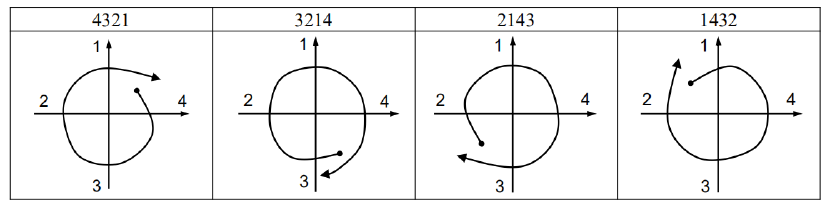
Figure 6. Code templates and schematic diagrams of clockwise circles.